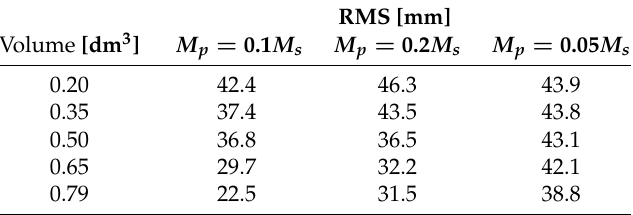
Table 2. Root Mean Square (RMS) of the displacement for various masses of the